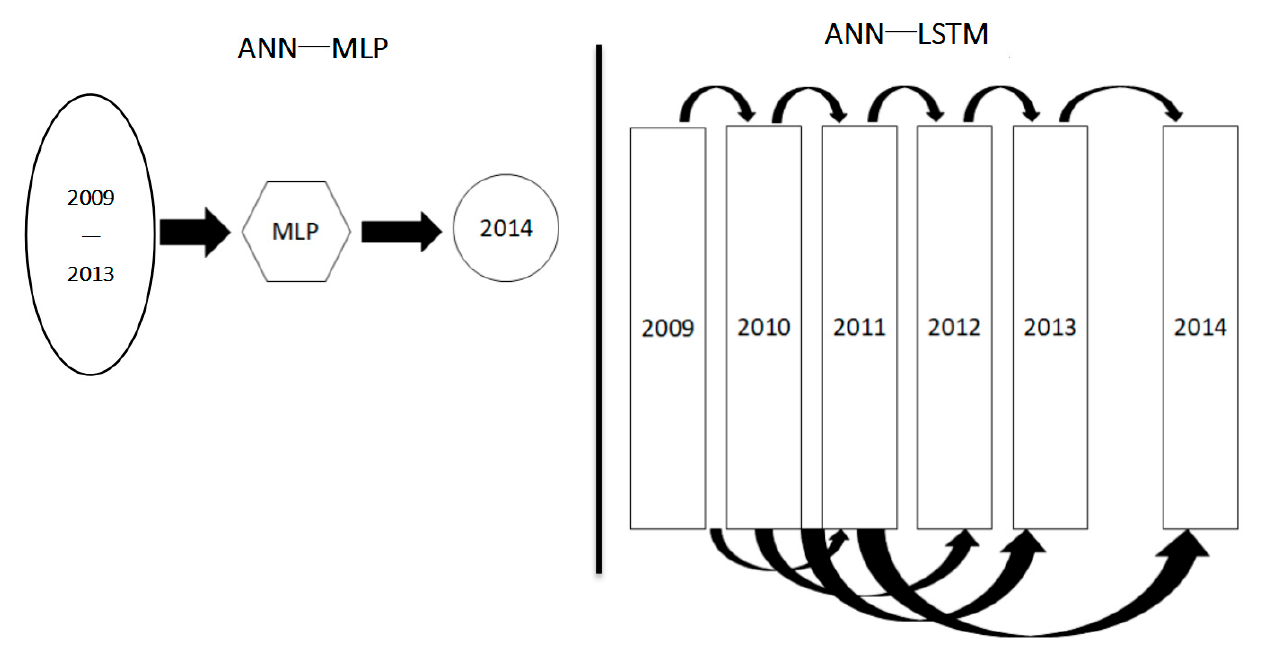
Figure 6. Differences between MLP and LSTM in dealing with annual land use data .